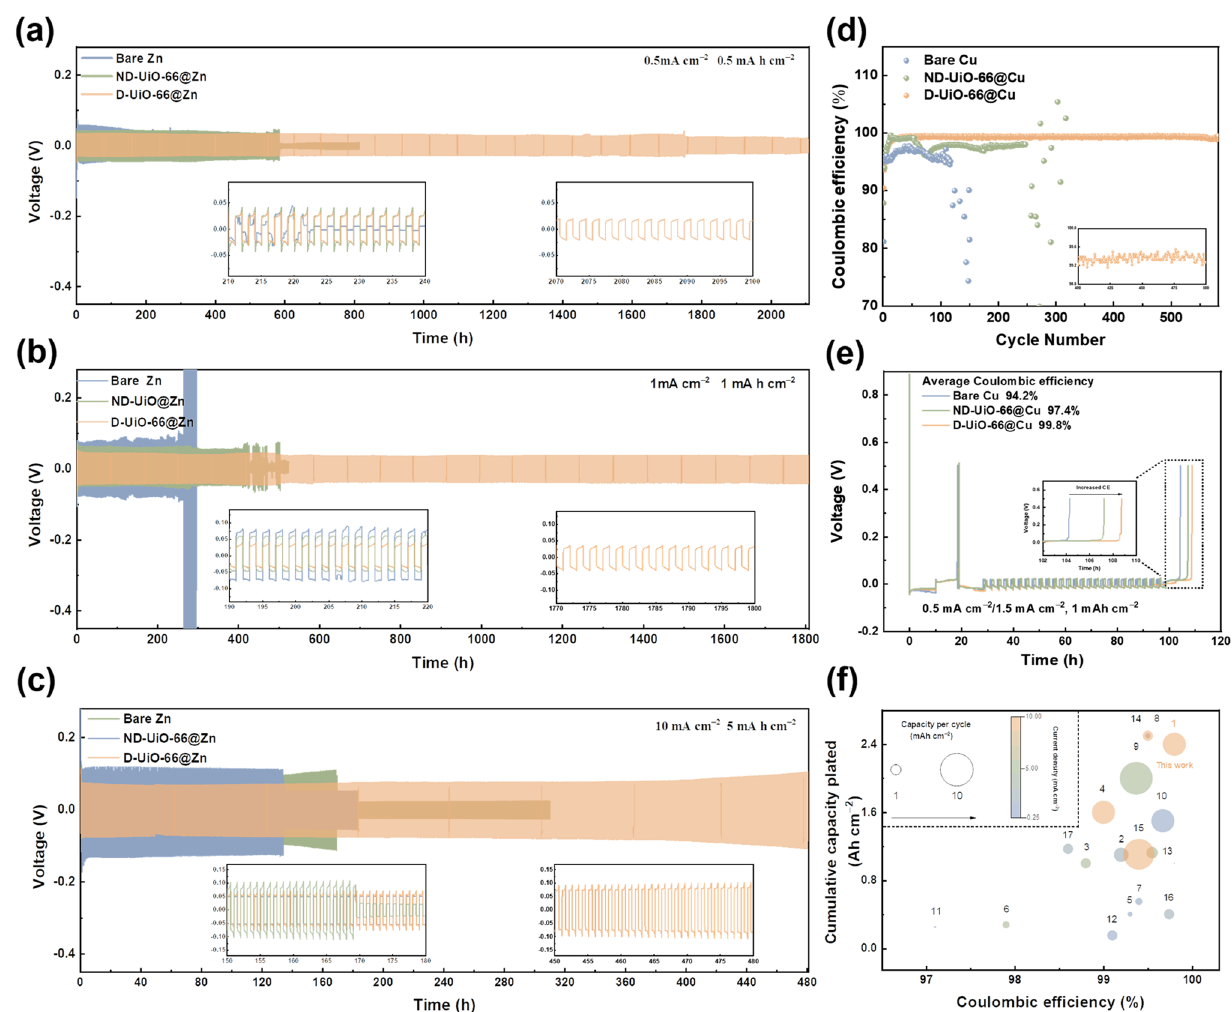
Fig. 4 Electrochemical Performance of half cells. Galvanostatic Zn plating/stripping of various zinc anodes in a symmetric cell at a 0.5 mA cm −2 and 0.5 mAh cm −2 , b 1 mA cm −2 and 1 mAh cm −2 , and c 10 mA cm −2 and 5 mAh cm −2 . d Coulombic efficiency (CE) of Zn plat- ing/striping on various electrodes at 1 mA cm −2 and 0.5 mAh cm −2 . e Voltage–time curves to measure the average CE of Zn plating/striping on various electrodes. f Comparison of per-cycle areal capacity, plating current density, CPC, and the CEs in recent reports. The detailed references corresponding to the point number and other related reports are listed in Table S3, supporting